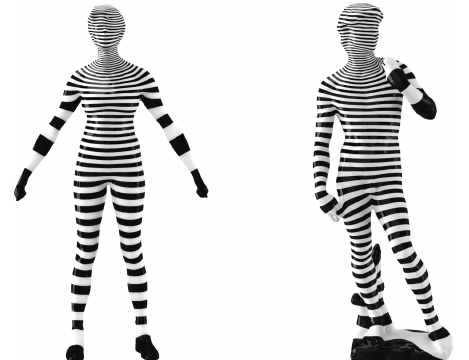
Figure 25. Example of Poisson fields on Triangulated meshes. In both characters, a single vertex, which is the highest node in the head of the character, was chosen to be the constrained vertex required to solve the Poisson equation. Observe how this scalar function follows the geometry of the